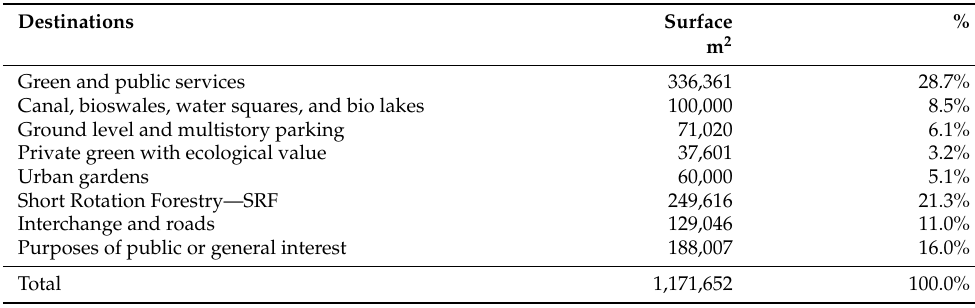
Table 6. Total assets of public areas, obtained through free